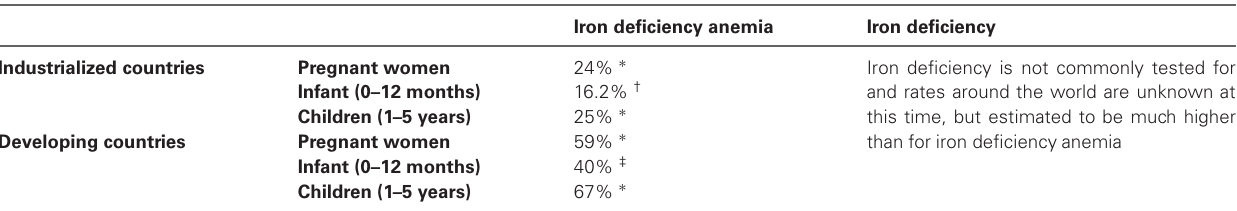
Table 1 | Prevalence of iron deficiency anemia around the